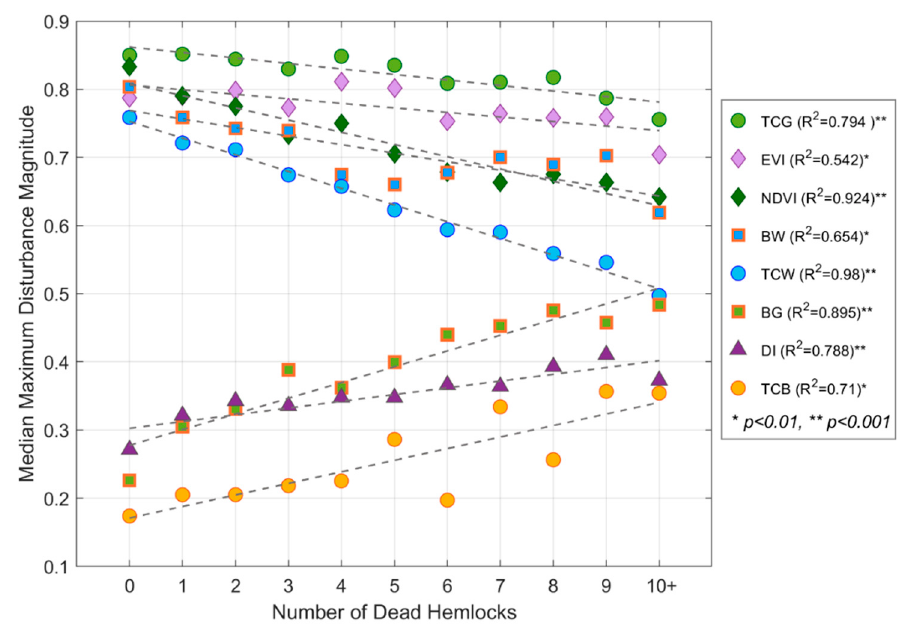
Figure 9. Linear regressions between the number of dead hemlocks and the median maximum disturbance magnitudes for the eight spectral indices from the pixels with the same number of dead hemlocks: TCB, TCG, TCW, NDVI, EVI, B / G, B / W, and DI (Table 1). All the regression lines are statistically significant ( p < 0.01).